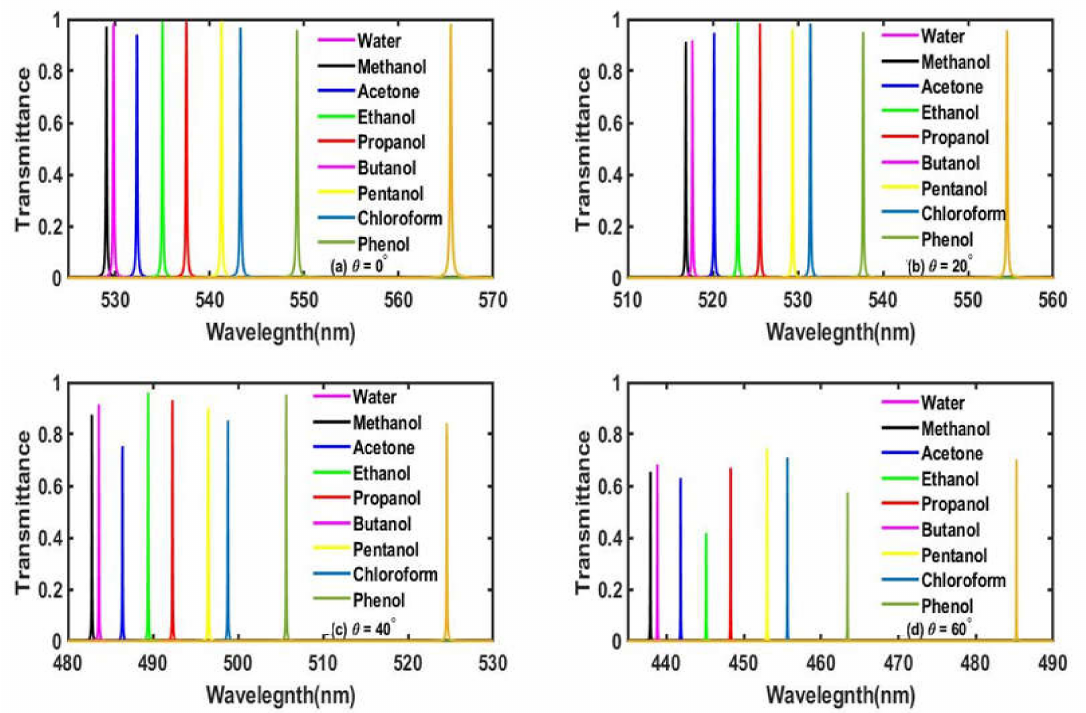
Figure 5. The transmittance spectra of the proposed bio-alcohol sensor loaded separately with water samples containing methanol, acetone, ethanol, propanol, butanol, pentanol, chloroform and phenol, each of a concentration of 30% with respect to the pure water sample at d c = 125 nm, corresponding to different incident angles ( a ) θ = 0 ◦ nm, ( b ) θ = 20 ◦ , ( c ) θ = 40 ◦ and ( d ) θ = 60 ◦